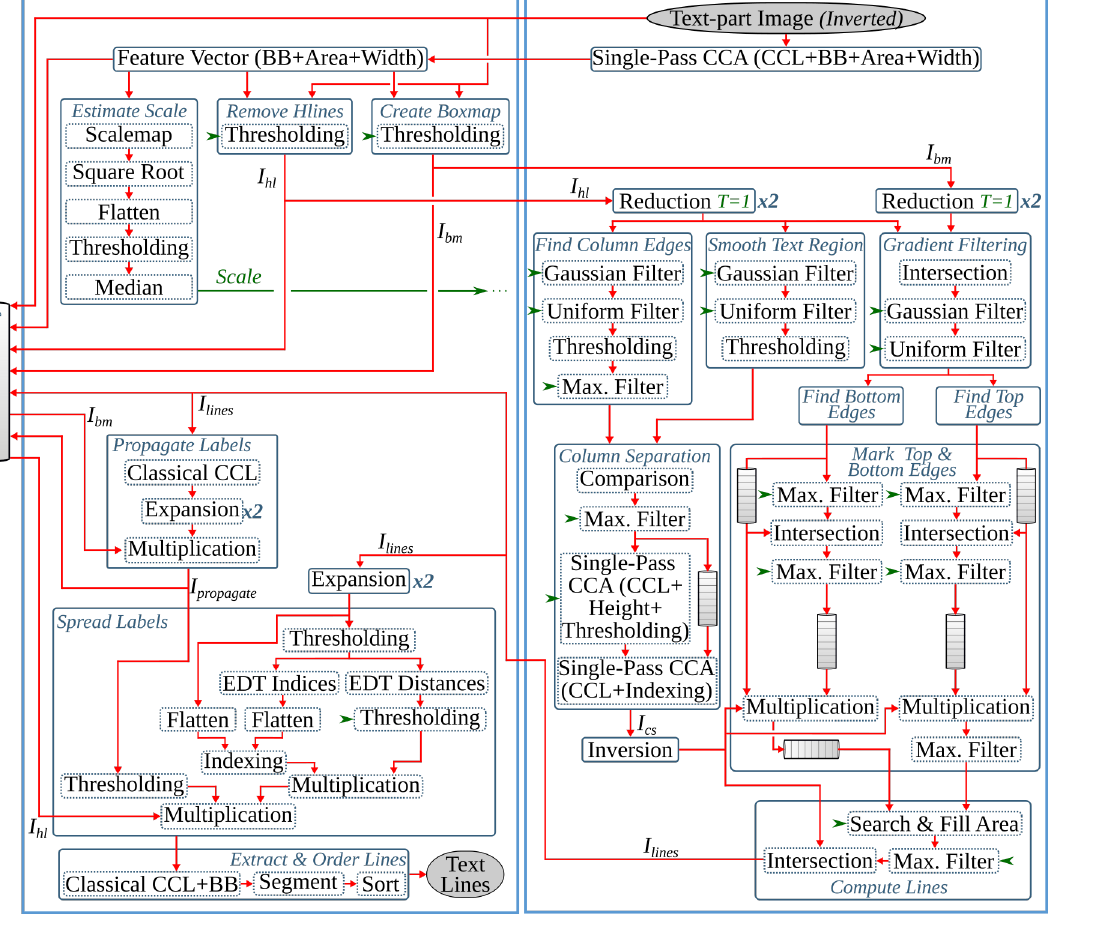
Figure 14. Hardware-software partitioning of text line extraction for the i DocChip